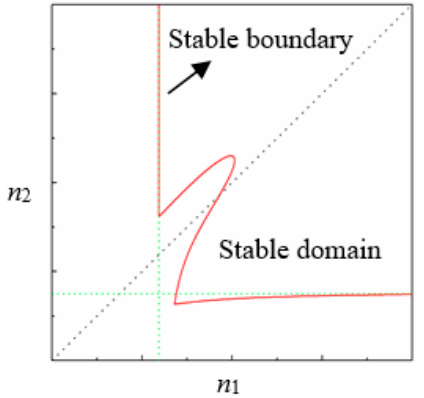
Figure 6. Stable domain of the hydro-turbine governing system with upstream and downstream double surge tanks [59].